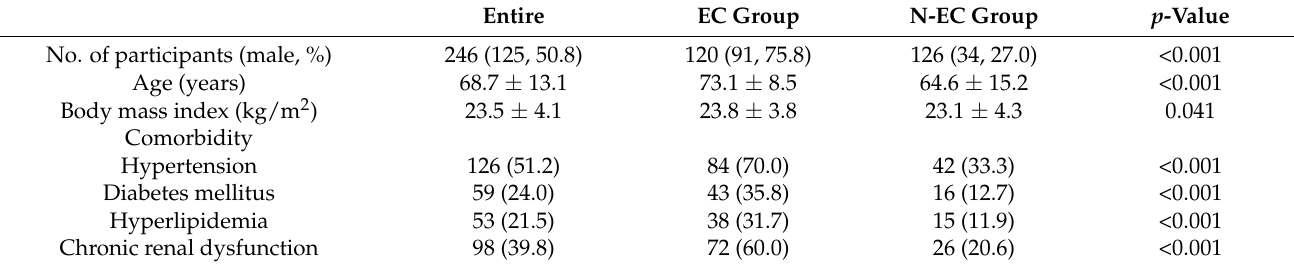
Table 2. General patient characteristics and differences between the two groups with and without EC. Entire EC Group N-EC Group p